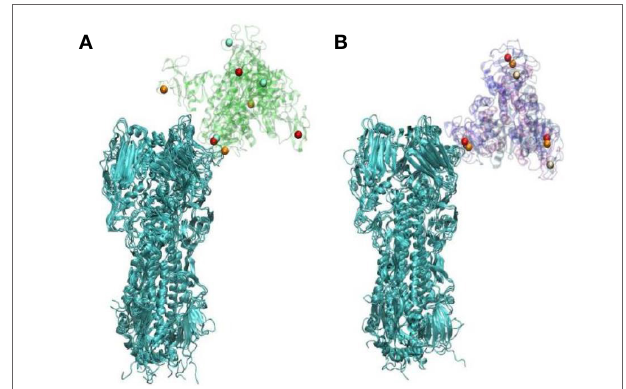
FiGURe 2 | Differences in orientation in hemagglutinin (HA) complexes with WT (A) or D325A + R343V (B) —this figure represents the endpoints of three repeated simulations. Calcium ions are represented in orange, red, and white; WT and D325A + R343V are in transparent cartoon representation in green and purple, respectively; HA is shown in cartoon representation in cyan [this figure was reprinted with permission from Goh et al. (79)].